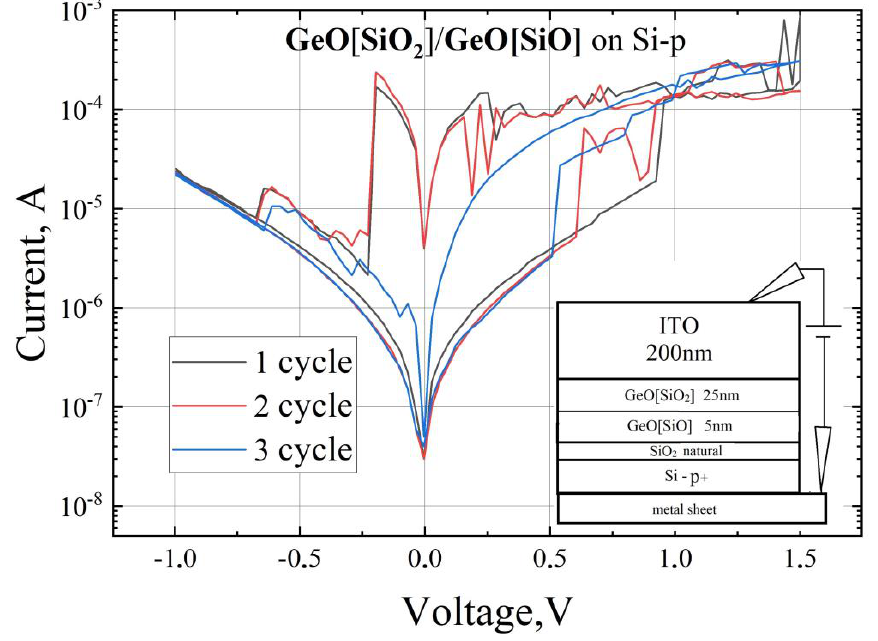
Figure 9. I – V curves of sample C. Figure 9. I–V curves of sample